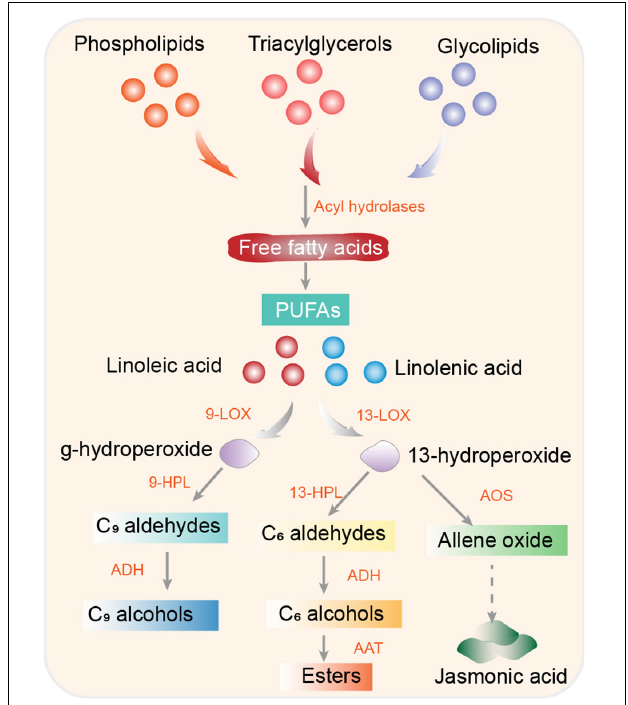
FIGURE 3 | Fatty acid derivative biosynthetic pathway. Fatty acid precursors (linoleic and linolenic acids) enter the LOX pathway and are converted to 9- and 13-hydroperoxide, which are oxidized and converted to volatiles by hydroperoxide lyase (HPL) and alcohol dehydrogenase (ADH). AAT, alcohol acyltransferase; ADH, alcohol dehydrogenase; AOS, allene oxide synthase; HPL, hydroperoxide lyase; LOX, lipoxygenase; PUFAs, polyunsaturated fatty